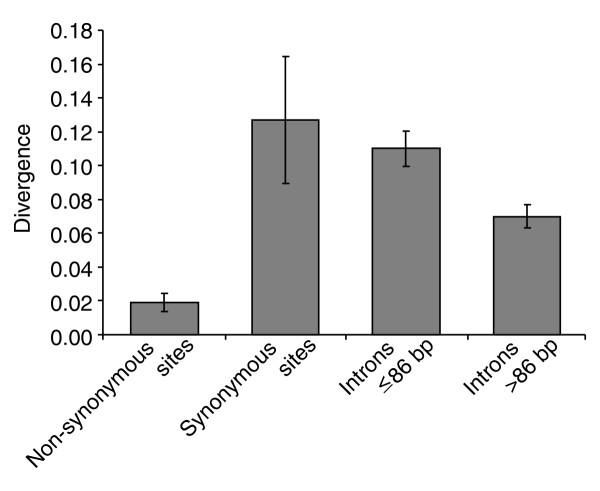
Mean divergences for non-synonymous sites, synonymous sites and both small and large introns. Mean levels of divergence between D. melanogaster and D. simulans for non-synonymous and synonymous sites of coding data, introns ≤86 bp and introns >86 bp. Error bars indicate two standard errors. Synonymous site divergence is significantly greater than large (Wilcoxon two-sample test statistic W = 7745.5, P < 10-4) but not small (W = 15115.5, P = 0.6173) intron divergences. Small intron divergence is significantly greater than large intron divergence (W = 17079.5, P < 10-4).